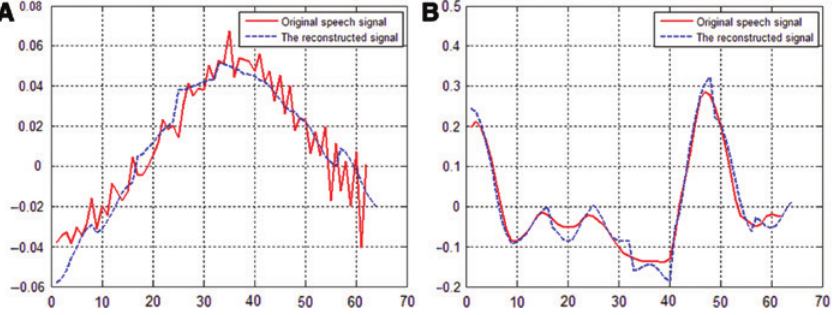
for Two Different Energy Level Frames. 10